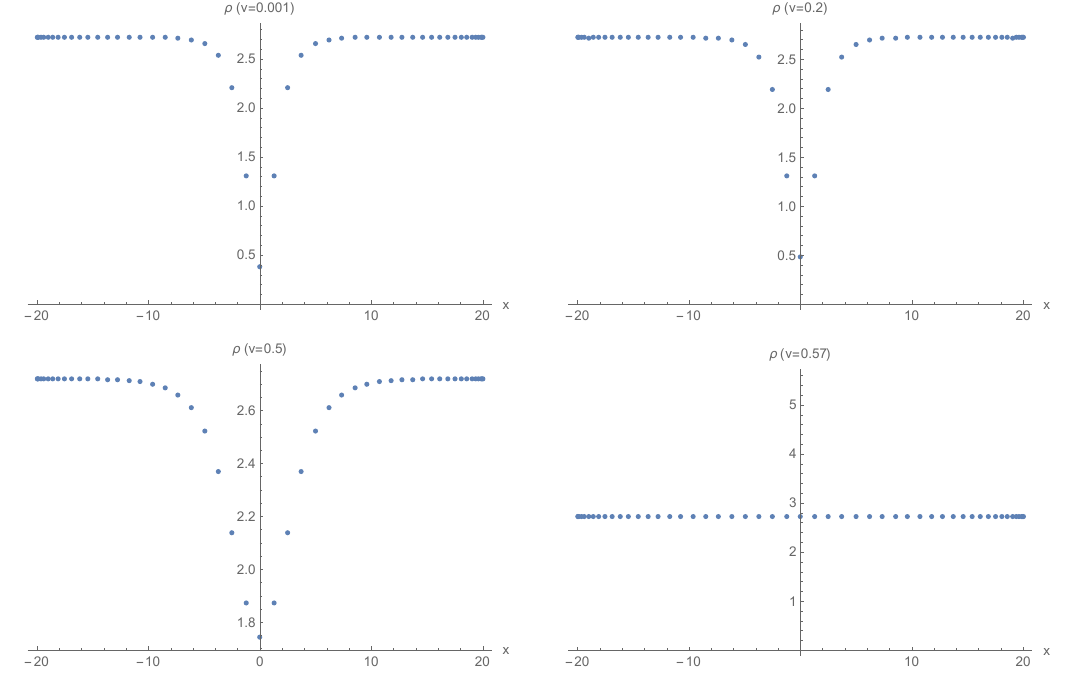
Figure 15 . The density distributions at various soliton speeds ( v = 0 : 001 ; 0 : 2 ; 0 : 5 ; 0 : 57) under the alternative quantization with the chemical potential (cid:22) = 1 : 3. The values of (cid:26) x =0 0.140459, 0.176112, 0.641066, 1 with the increasing